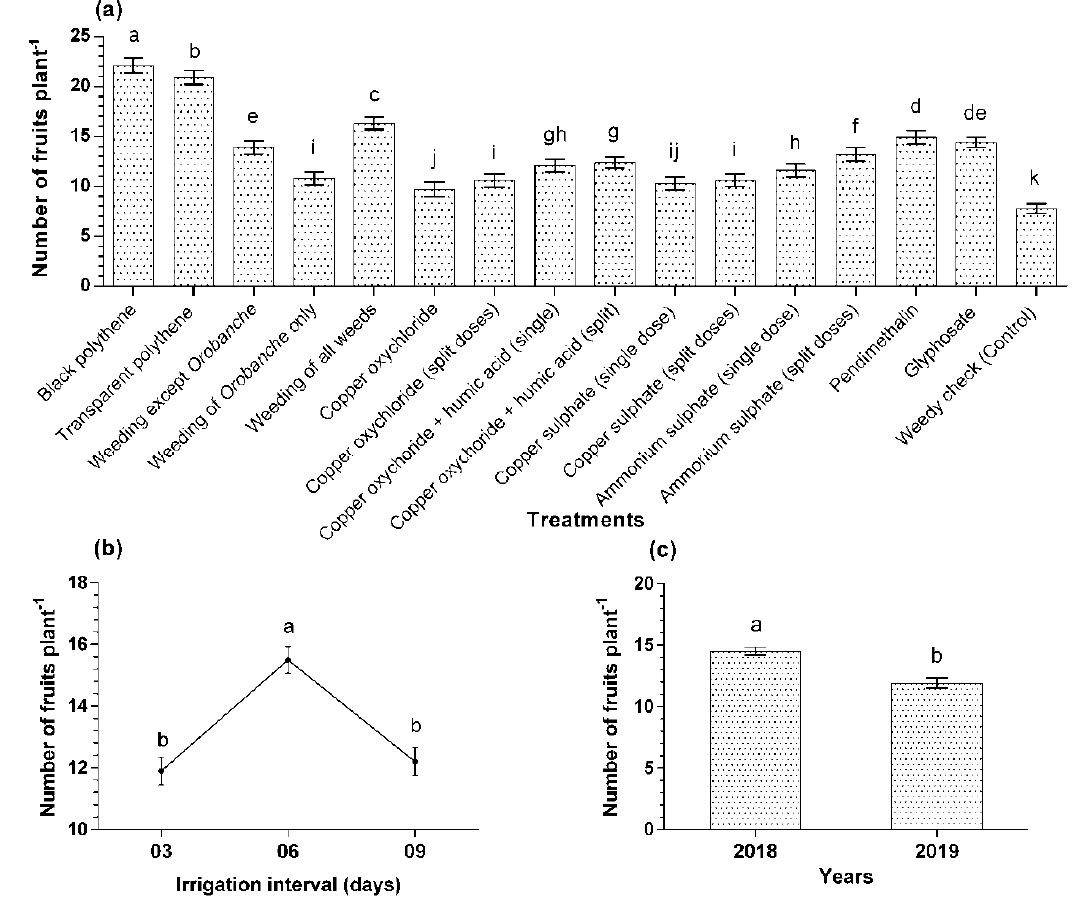
Figure 11. Effect of irrigation intervals and weed management treatments on the number of fruits plant − 1 of tomato. Based on the Least significant difference test, line and column ± standard error followed by different alphabetical letters are significantly different from each other at a 5% level of probability . ( a ) Effect of treatments on the number of fruits plant − 1 of tomato. ( b ) Effect of irrigation intervals on the number of fruits plant − 1 of tomato. ( c ) Effect of different years on the number of fruits plant − 1 of tomato.